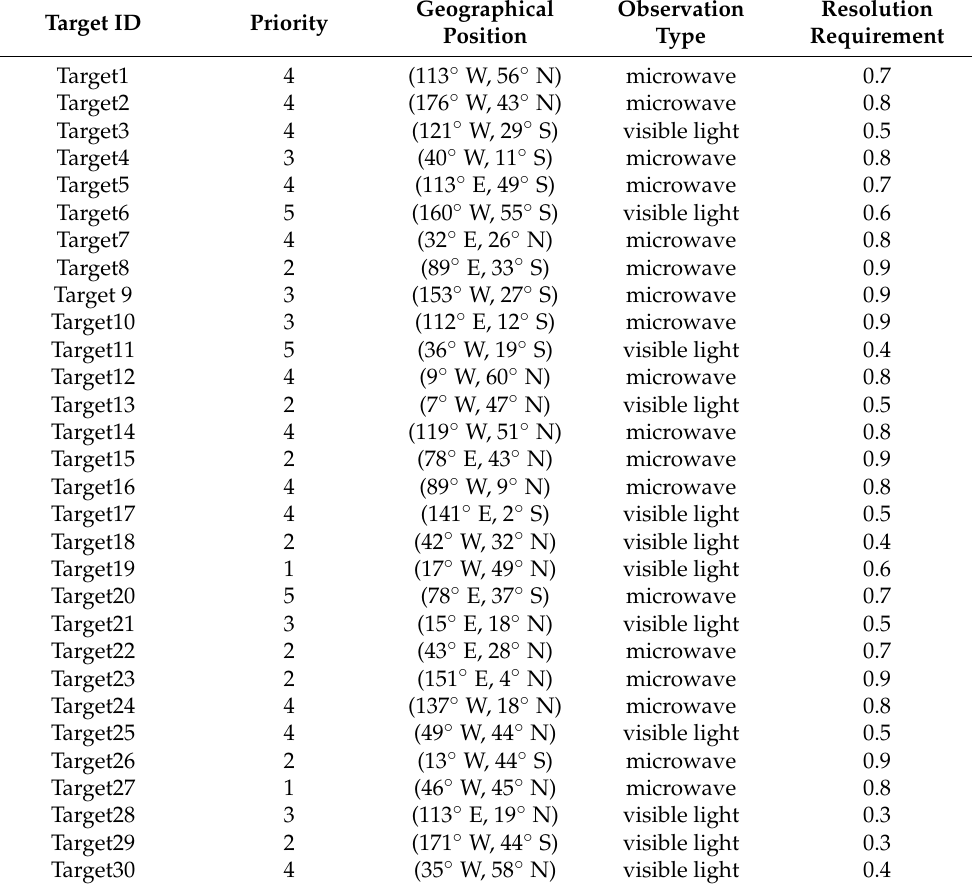
Table 4. Initial target parameters.